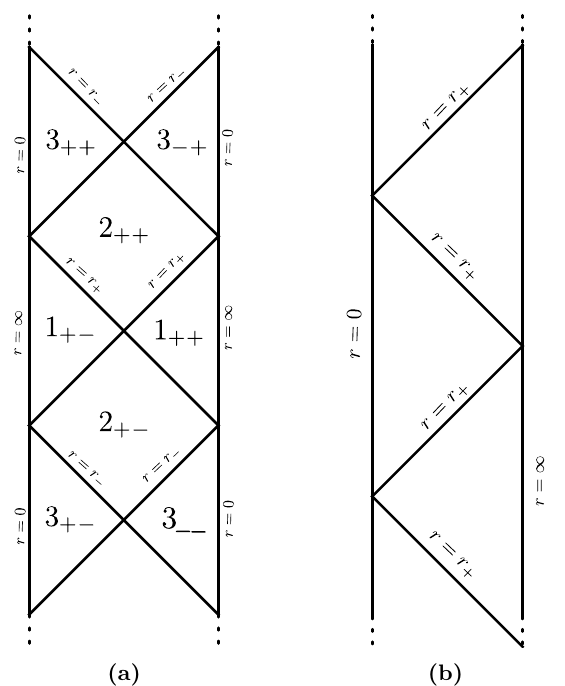
Figure 1 . (a) Penrose diagram for maximally extended rotating BTZ (non-extremal). Regions 1 + (cid:6) : r > r + . Regions 2 + (cid:6) : r (cid:0) < r < r + . Regions 3 (cid:6)(cid:6) : r < r (cid:0) . (b) Penrose diagram for the extremal limit r + = r (cid:0)